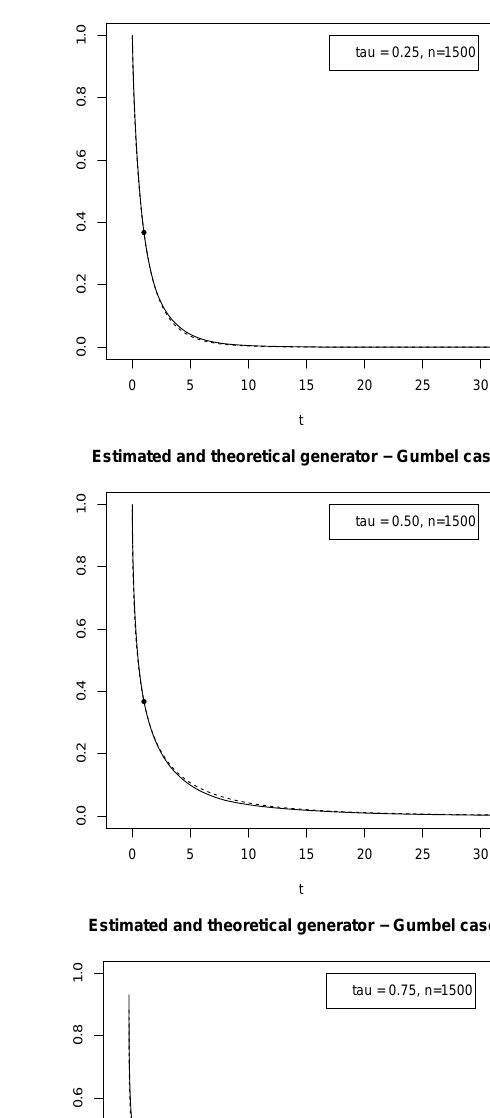
,φ , e − 1 ) (black 0 0 ) = (1